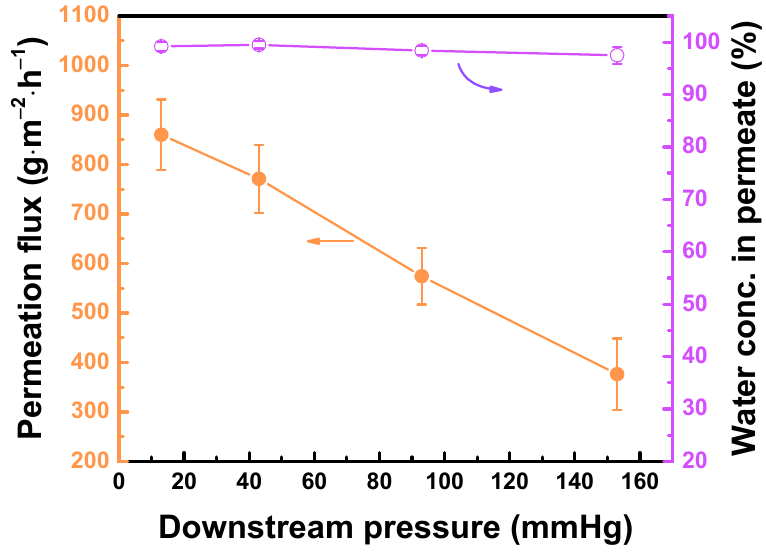
Figure 9. TFC isopentane membrane performance at different downstream pressure. Feed = 90 wt% aqueous ethanol solution at 25 °C.